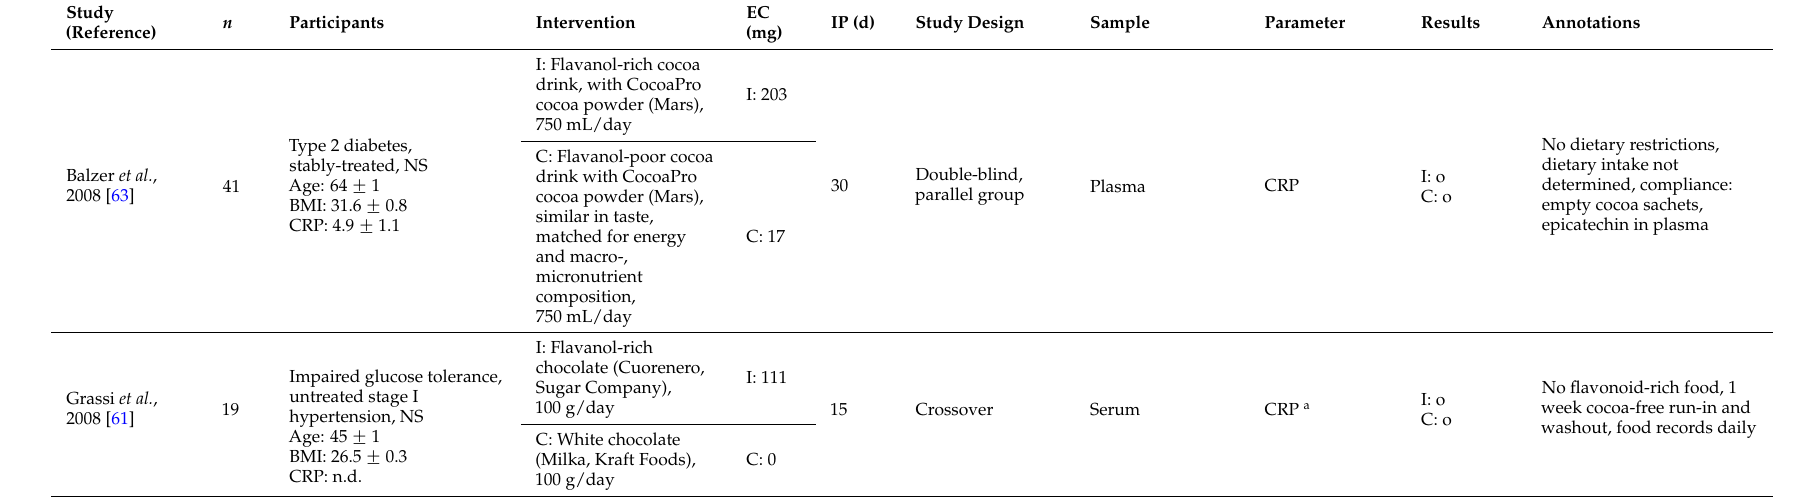
Table 4. Effect of regular cocoa consumption on inflammation in patients with type 2 diabetes or impaired glucose tolerance—results from randomized, controlled trials. Study n Participants Intervention EC (Reference) (mg) IP (d) Study Design Sample Parameter Results